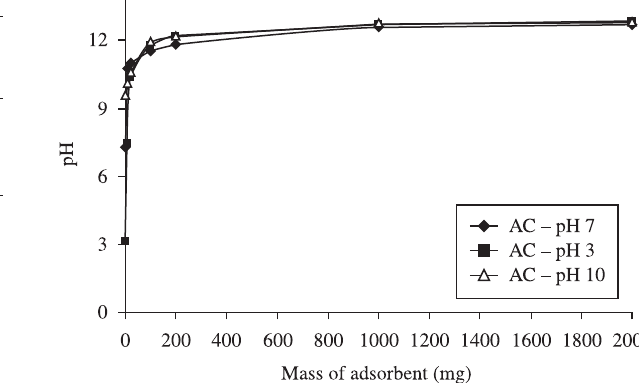
Figure 3. Point of zero charge of AC adsorbent by mass titration.